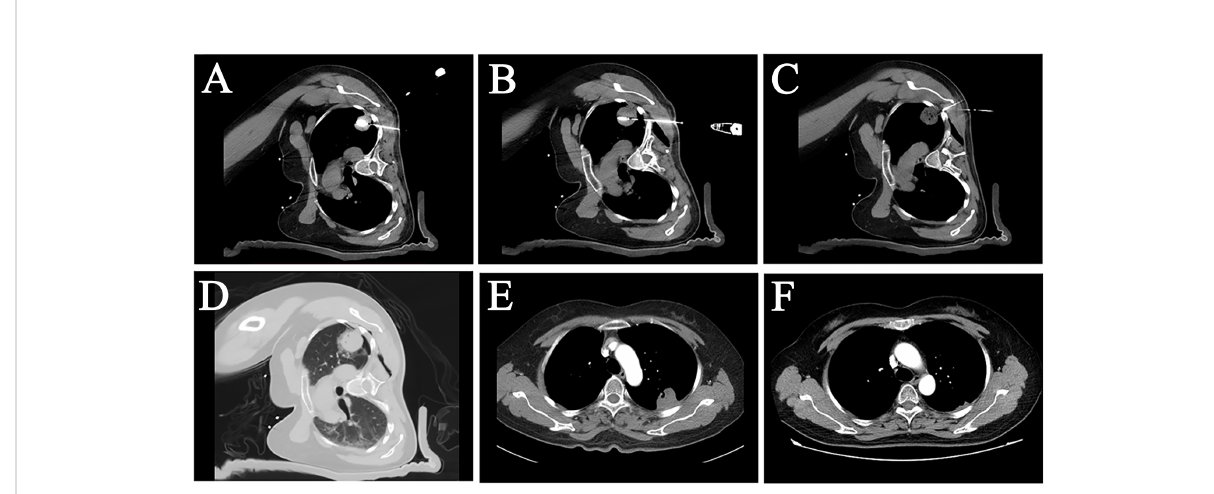
FIGURE 2 A female patient, 50 years old, with pulmonary metastasis from osteosarcoma, which was eradicated with an MWA procedure with LPA. (A, B) CT image showed a sizeable subpleural metastasis in the upper lobe of the patient ’ s left lung. Two MWA antennas were used on the patient at different layers to perform MWAof this metastatic tumor. (C) Local pleural anesthesia was used on the patient during the treatment. The tip of the anesthesia needle was placed in the subpleural area near the tumor. (D) An immediate postoperative CT scan showed a “ halo sign ” surrounded by a ground-glass density around the lesion. (E) A follow-up examination three months after surgery showed that the lesion was smaller than before, and no abnormal enhancement was seen inside the lesion. (F) Twelve months later, the tumor largely disappeared, suggesting that the pulmonary metastasis had achieved radical